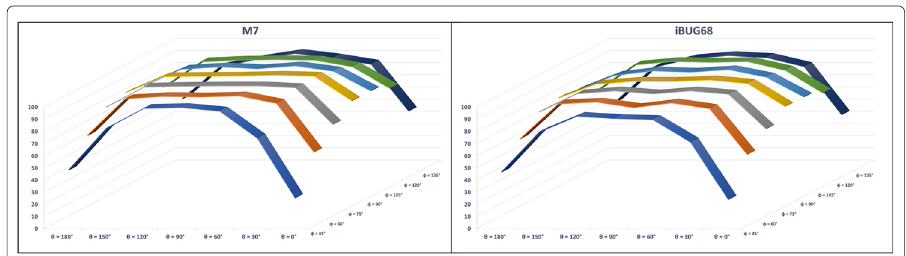
Fig. 12 3DFan: camera position varying across φ (from 45 ◦ to 135 ◦ ) and θ (from 0 ◦ to 180 ◦ )